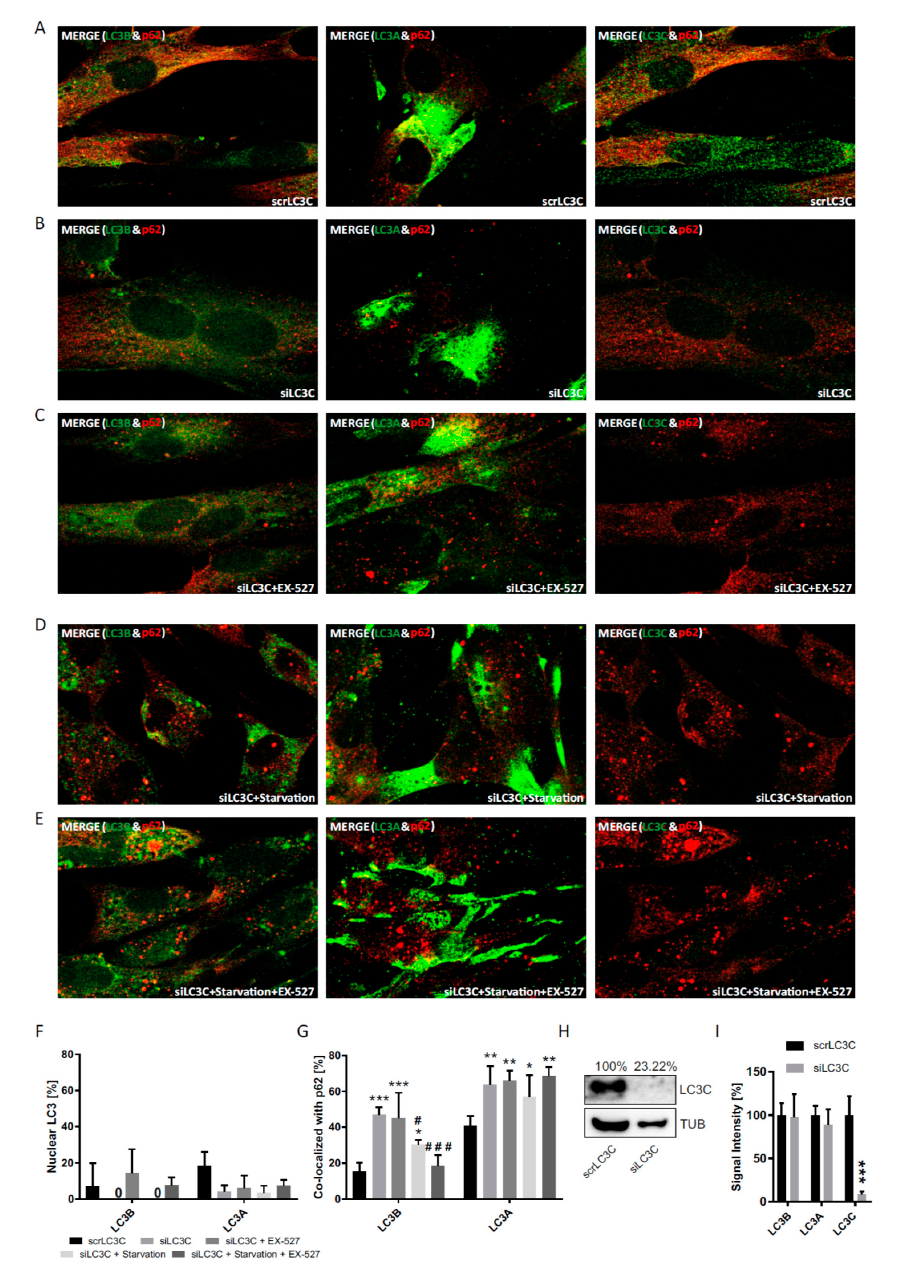
scrLC3A: ** p ≤ 0.01; *** p ≤ 0.001; significant changes versus siLC3A: # p ≤ 0.05; ## p ≤ 0.01. ( H ) LC3A protein expression in cells transfected with scrLC3A-RNA or siLC3A-RNA. Tubulin was used as loading control. ( I ) Control of knock-down and antibody specificity under immunocytochemistry conditions. Whole-cell signal intensities were quantified and evaluated by two-way ANOVA. Data in ( F ), ( G ) and ( I ) were derived from three photographed, independent experiments ( n = 3), in which 12– 45 cells per image were analyzed.